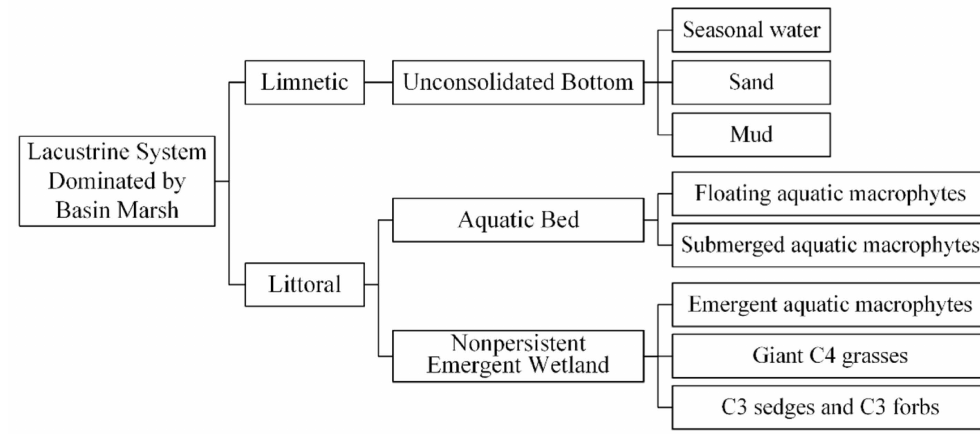
Figure 3. PFT classification scheme in this analysis.